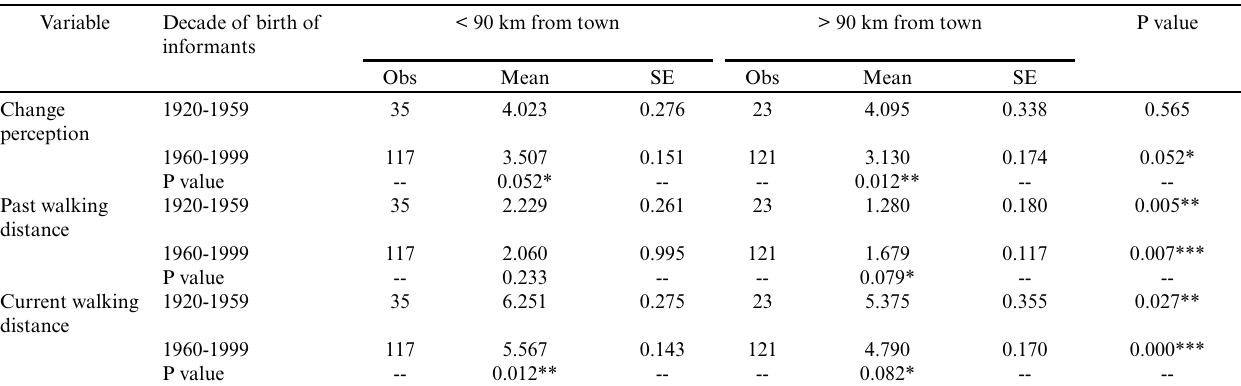
Table 3 . Differences in the perception of change per decade of birth between villages closer and farther from town.